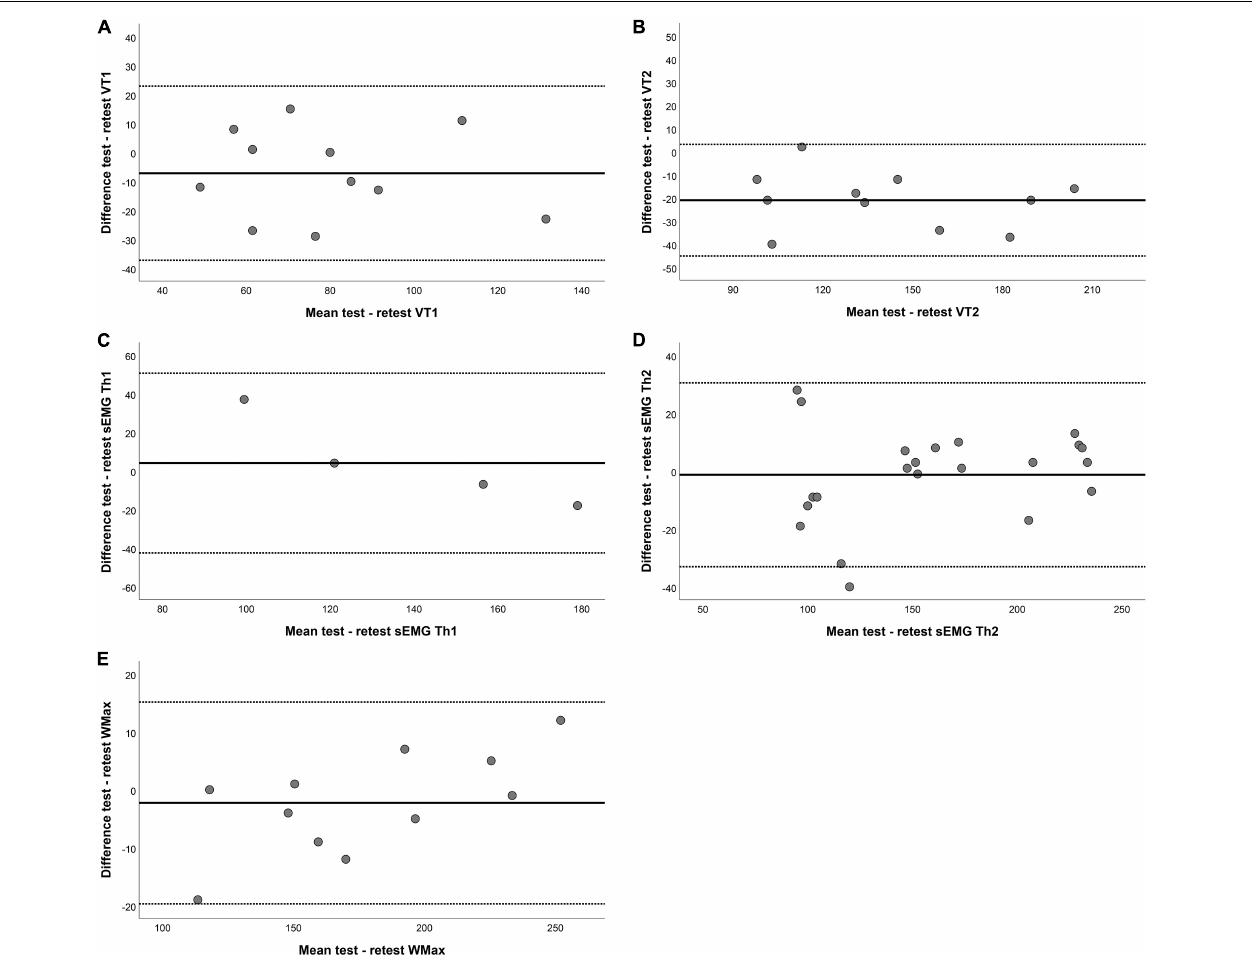
FIGURE 3 | Bland–Altman plots for test–retest reliability of (A) the first ventilatory threshold (VT1), (B) the second ventilatory threshold VT2, (C) the first surface EMG threshold (sEMG Th1), (D) the second surface EMG threshold (sEMG Th2), and (E) maximum power (Pmax). The horizontal lines represent the mean difference (bias) and two standard deviations, i.e., limits of agreement of the differences between the test and retest.